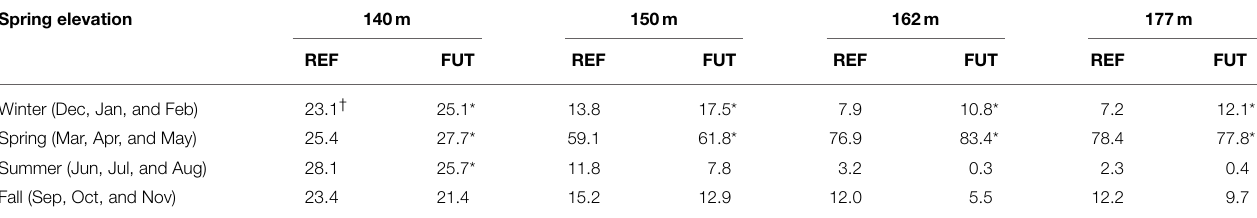
TABLE 2 | Percentage distribution of spring activity per season for the reference (REF) and the future periods (FUT), and for the four spring elevations (Adapted from Levison et al., 2014b). Spring